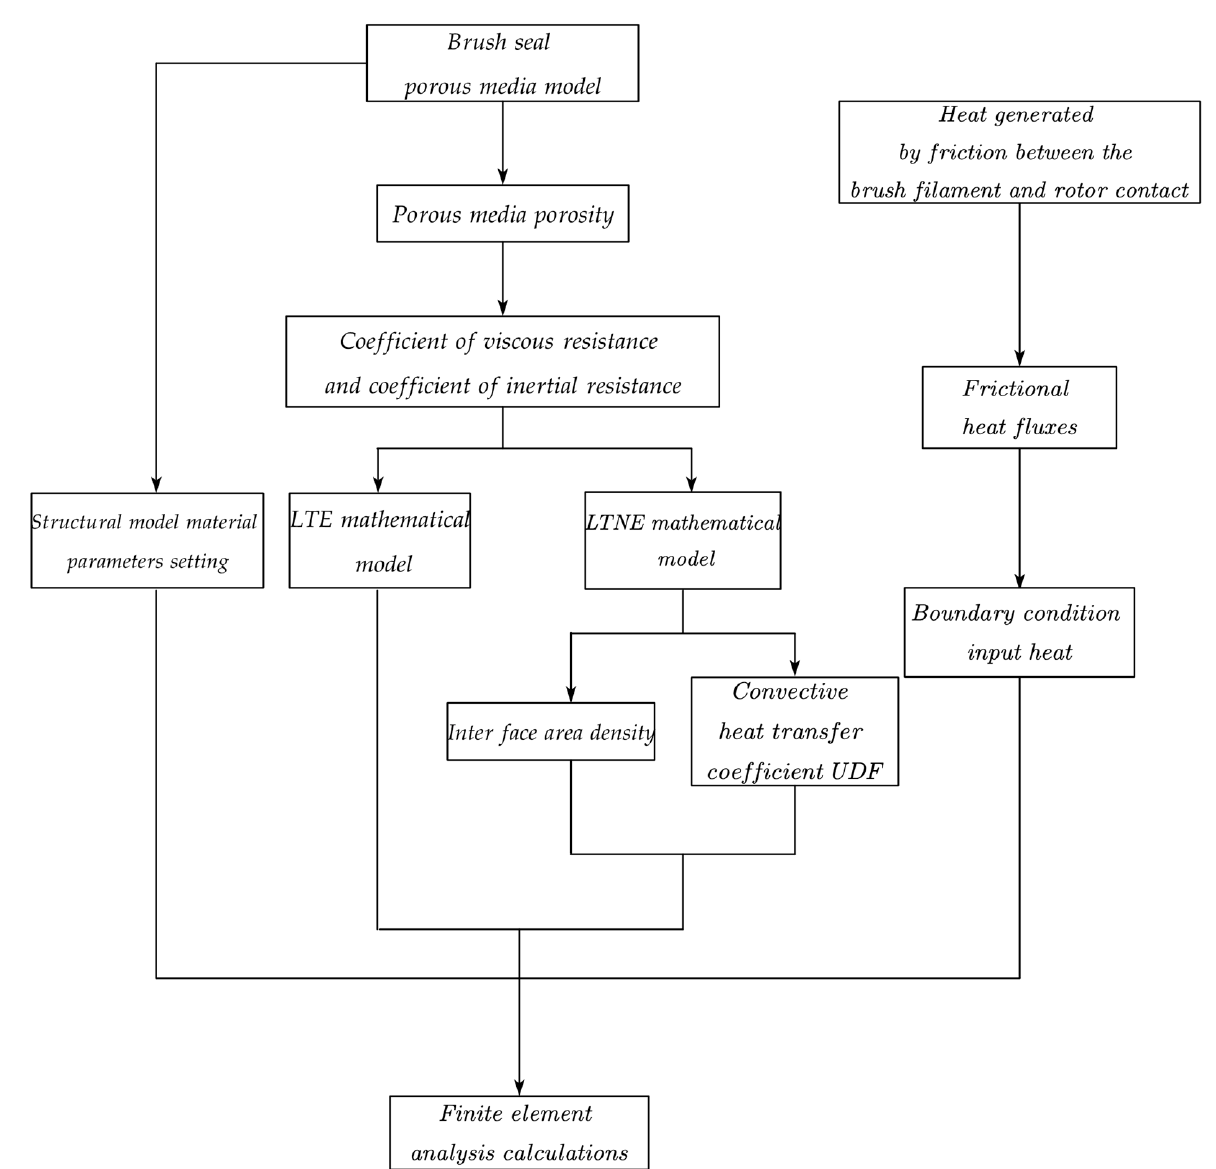
Figure 2. Flow chart of formula calculation.